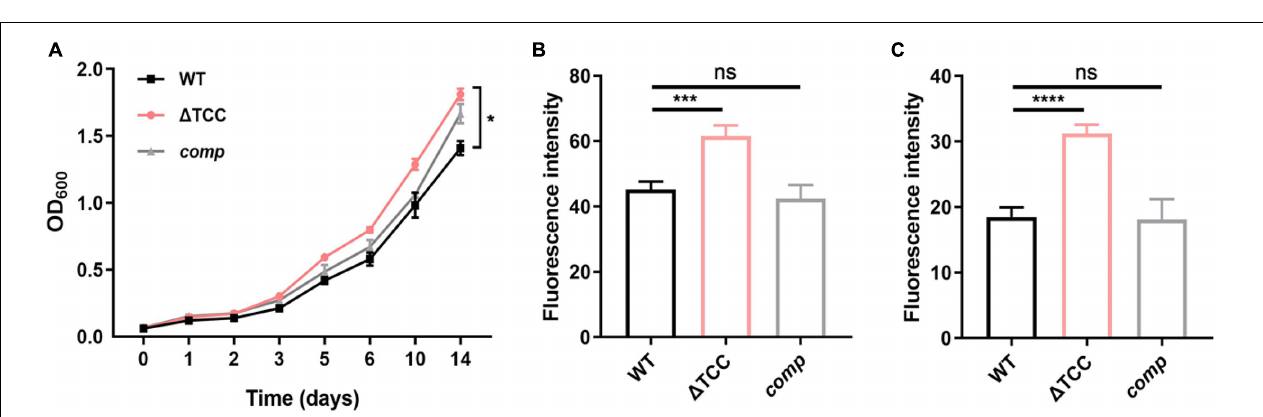
FIGURE 2 | The effect of TCC deletion on mycobacterial cell wall permeability. (A) WT, TCC deletion mutant, comp strains were grown to mid-log phase, washed. Bacteria were diluted to an initial OD 600 of 0.05 and the OD 600 was monitored at the designated time points. Cell growth was monitored by OD 600 measurements ( n = 3 biological replicates per group, data are shown as the mean ± SEM, two-way ANOVA with Tukey’s multiple comparison test, compared with WT group; * p < 0.05). (B,C) WT, TCC deletion mutant, comp strains were grown to mid-log phase, washed, and stained with (B) Nile red or (C) ethidium bromide, and fluorescence was measured ( n = 3 biological replicates per group, data are shown as the mean ± SEM, one-way ANOVA with Dunnett’s multiple comparison test, compared with WT group; ns, not significant; *** p < 0.001, **** p < 0.0001).